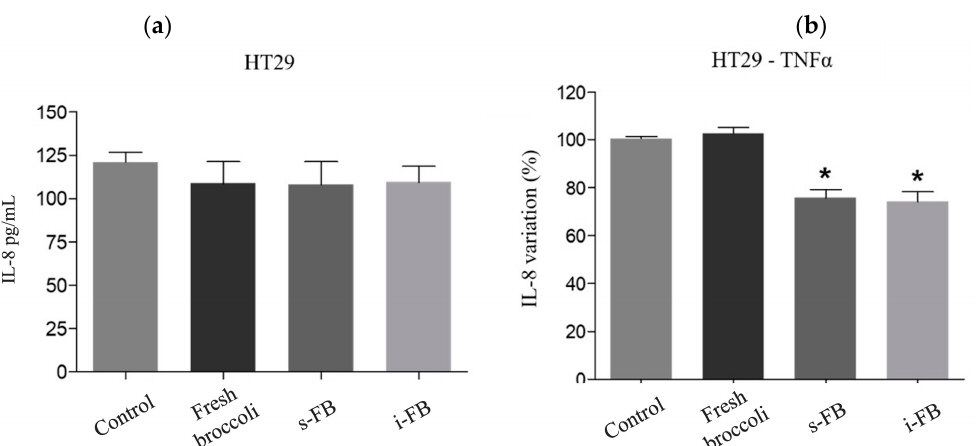
Figure 7. Effects of fermented broccoli extracts on IL-8 production by HT-29 cells. ( a ) No stimulation and ( b ) stimulated with TNF α . Cytokine production after co-incubation of fermented broccoli extracts and HT-29 cells for 6 h was analyzed using ELISA. The results are expressed as the percentage of induction of the HT-29/TNF α ±SEM. Asterisks (*) indicate significant differences compared to the Control group ( p < 0.05). Control (PBS-7% methanol) = 3562 pg/mL.